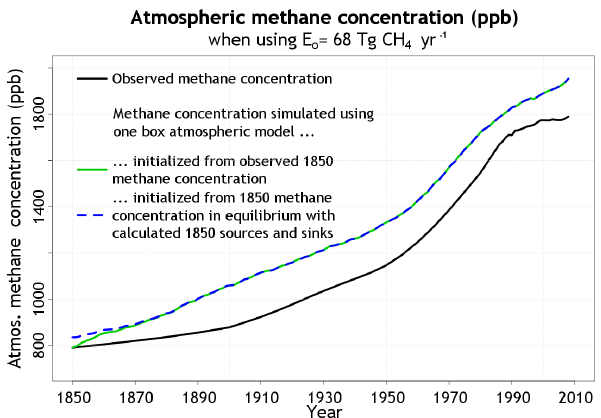
Figure 10. Simulated methane concentration over the historical period, together with its observation-based values, when other non-wetland natural methane emissions ( E o ) are specified at 68TgCH 4 yr − 1 over the historical